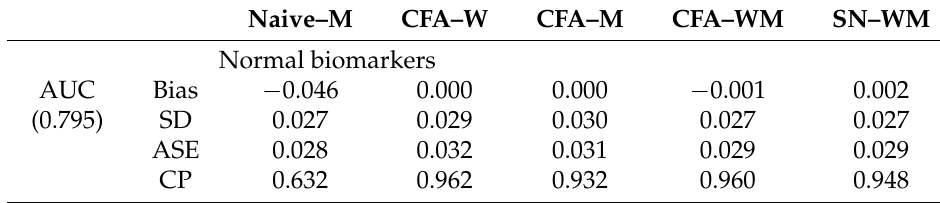
Table A1. Simulation study when σ u = σ v = 0.71